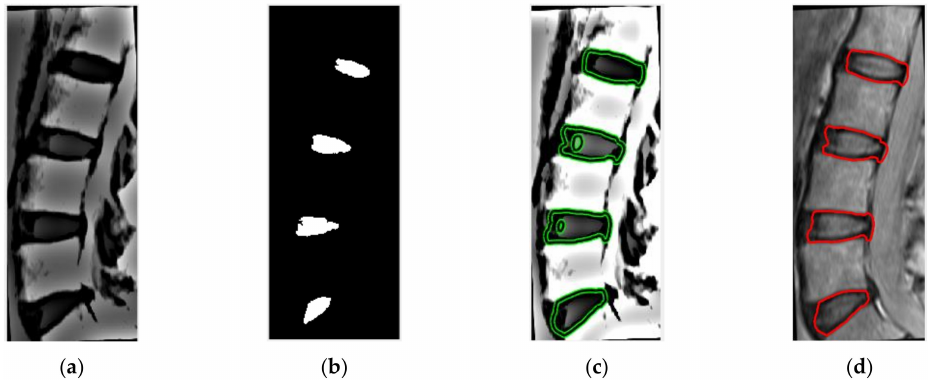
Figure 7. ( a ) Unsharp mask applied to registered MR image, ( b ) binary image derived from stage 4, used for active contour initialization, ( c ) active contour applied on contrast-enhanced images with 40 iterations, ( d ) IVD boundary extraction.